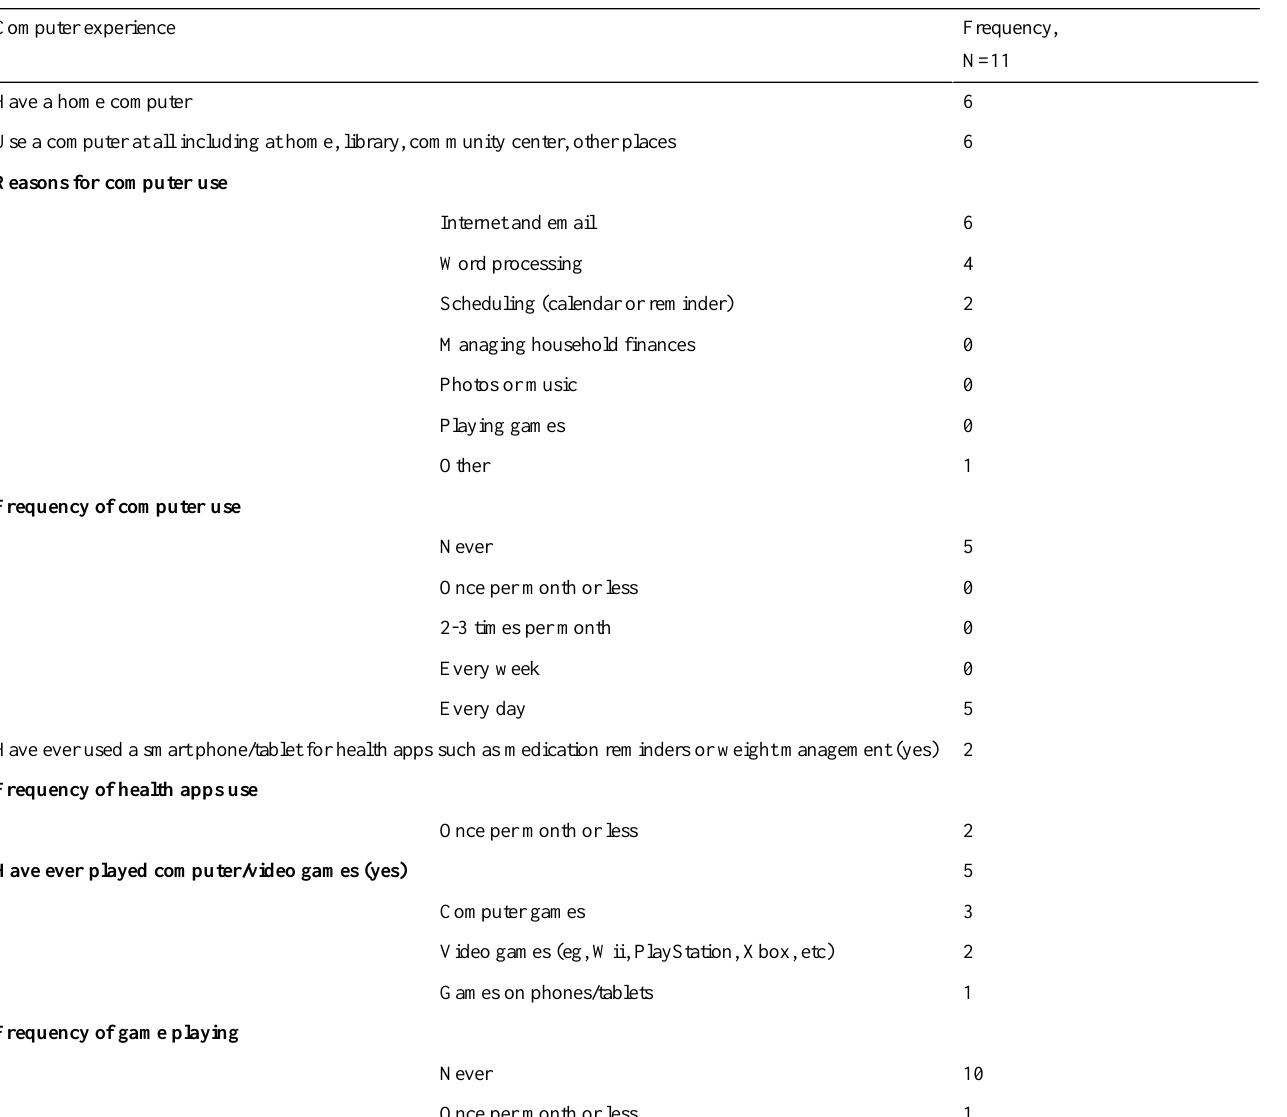
Table 3. Participants’technology related